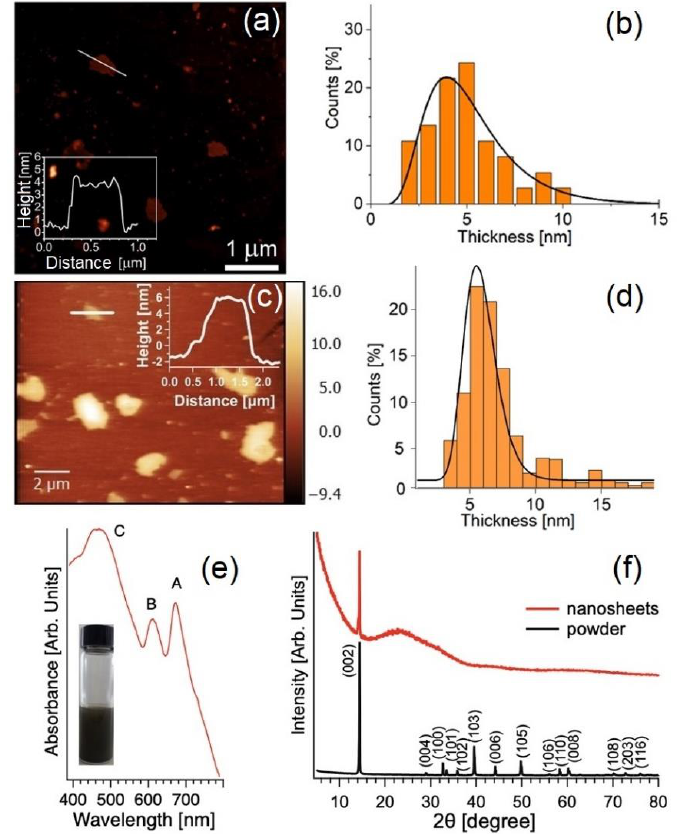
Figure 3. Representative AFM image of MoS 2 flakes in ( a ) Polarclean (taken from [70] with permission) and ( c ) Iris. The height profile along the white solid line is reported in the inset. Analysis of the thickness distribution ( b , d ) was determined from the AFM measurements. ( e ) UV – VIS spectrum of the MoS 2 nanosheets produced by Iris-assisted LPE. ( f ) XRD pattern of the (black curve) powdered MoS 2 bulk crystals and (red curve) exfoliated nanosheets of MoS 2 .